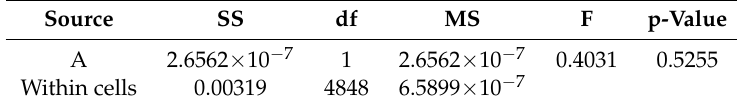
Figure A16. Tree graph for the analysis of the effect of factor A on the expected uncertainty performance. The dashed node and arc correspond to a rejected conclusion due to multimodal population. The arc in blue represents a decision on the value of factor B based on a forced interaction. Table A3. One-way ANOVA table for factor A given B = 2.